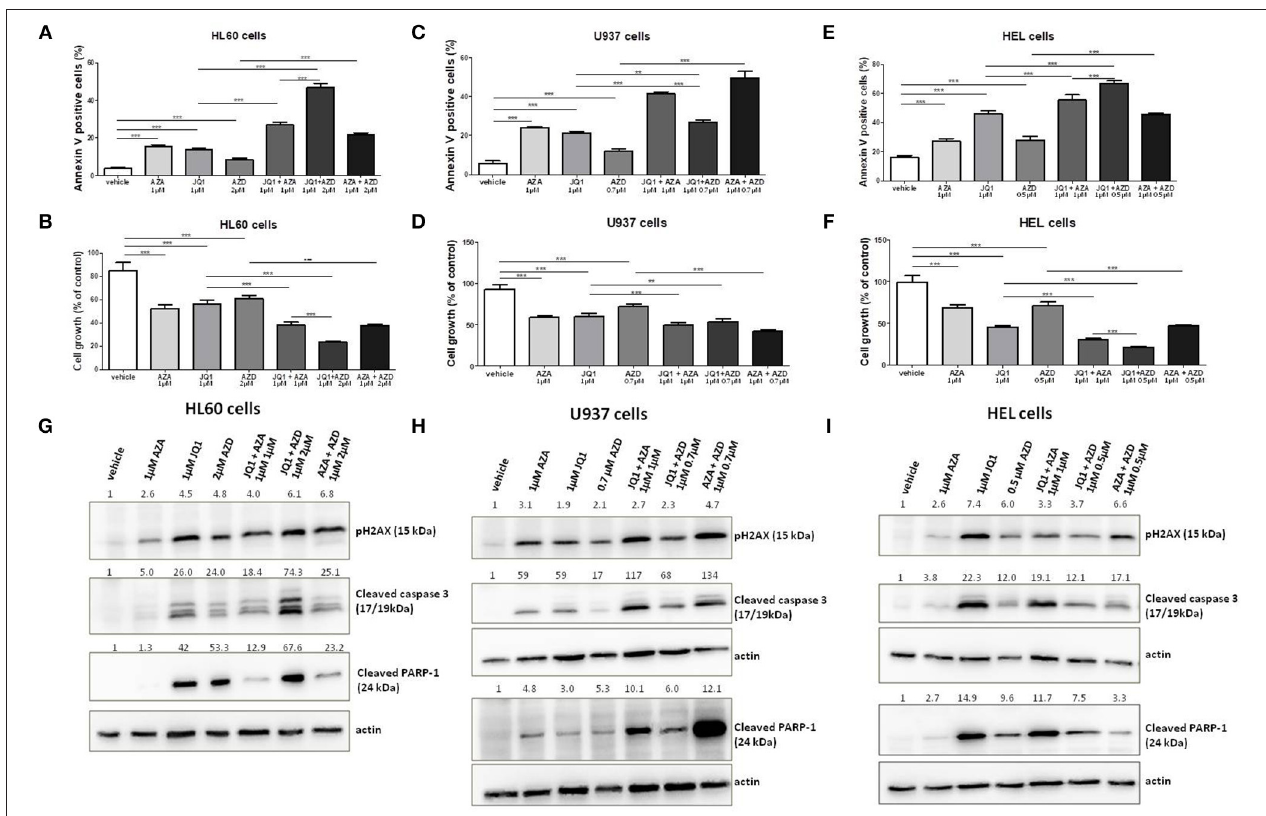
FIGURE 5 | JQ1 effects on apoptosis of leukemia cell lines are increased with the ATR inhibitor AZD6738. Apoptosis rate and cell growth percentage in HL60 (A,B) , U937 (C,D) , and HEL (E,F) leukemia cell lines treated with AZA, JQ1, or AZD6738 monotherapy or in double combinations in the indicated doses for 48h. Protein expression levels of pH2AX, cleaved caspase 3, and cleaved PARP-1 in HL60 (G) , U937 (H) , and HEL (I) leukemia cell lines treated with AZA, JQ1, or AZD6738 monotherapy or in double combinations in the indicated doses for 48h. Actin (42 kDa) was used as a control for equal sample loading and the membrane was developed with the ECL Western Blotting Analysis System. Densitometry was performed and the ratio of target proteins vs. actin compared with the normalized value of control is shown. All bar graphs represent mean ± SD of at least four independent experiments. ** P ≤ 0.01; *** P ≤